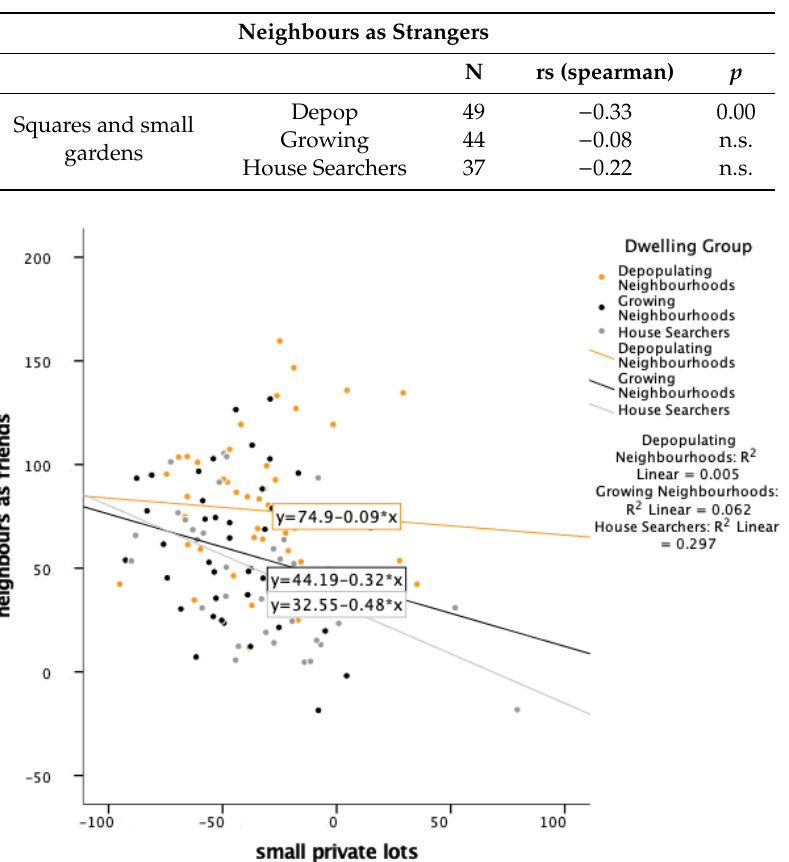
Table 5. Significance and correlation coefficients rs between the levels “small private and semi-private lots” and “neighbours as friends”, according to the subgroups: “depopulating neighbourhoods”, “growing neighbourhoods”, and “house searchers”.